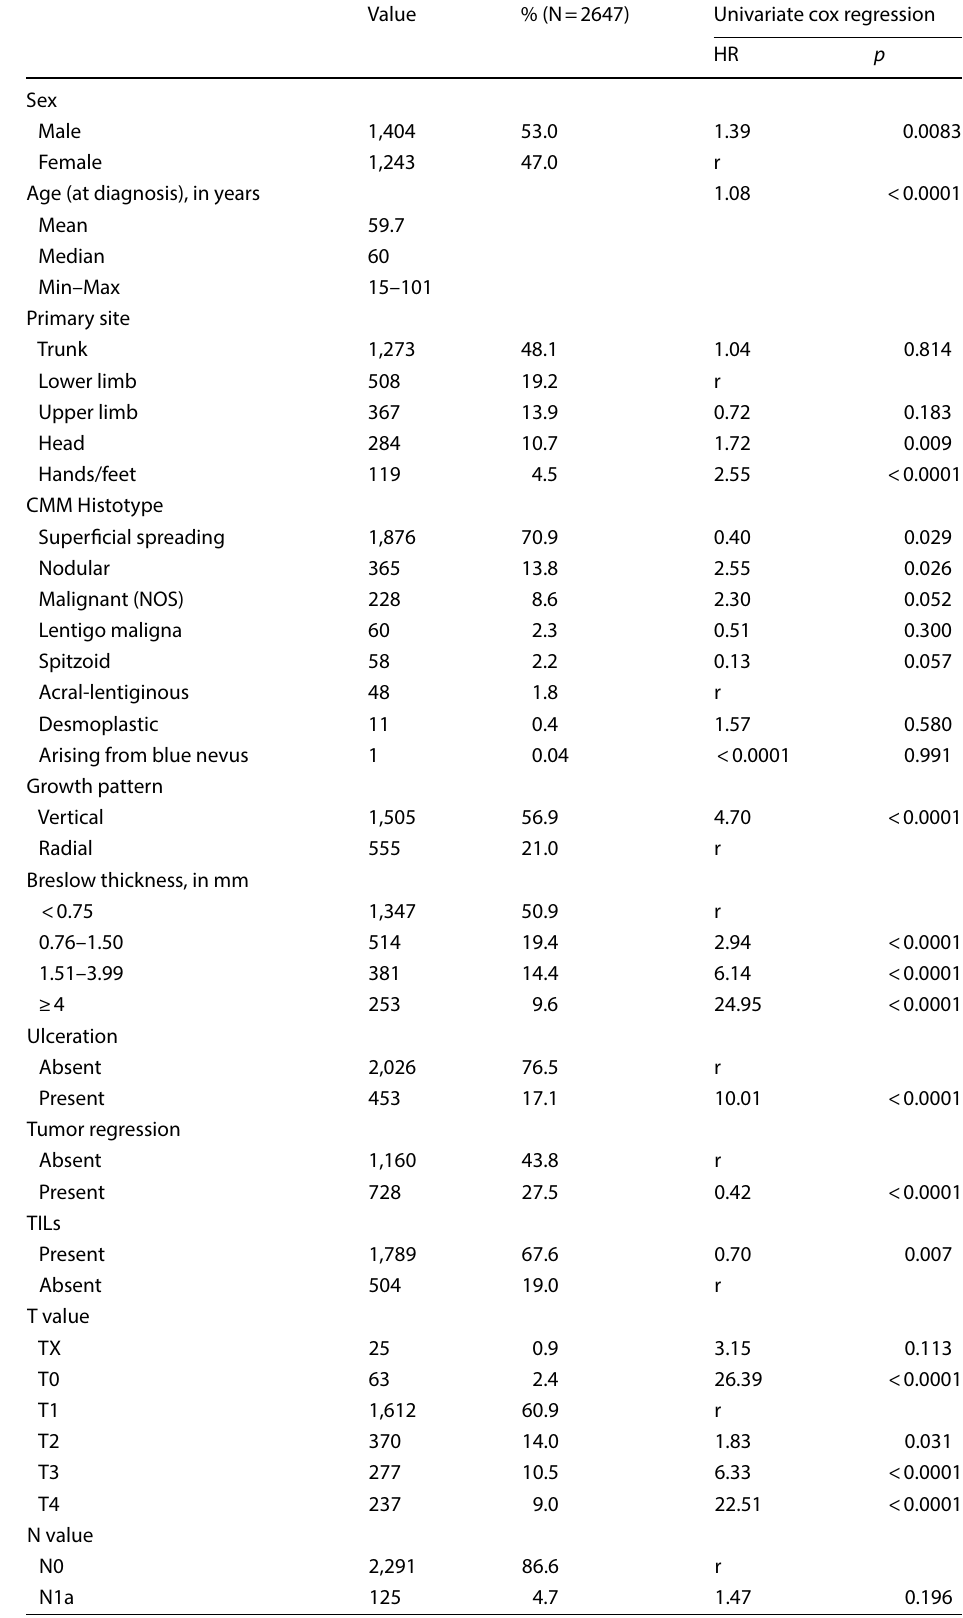
Table 1 Clinical-pathological characteristics of the study population and univariate Cox regression hazard ratio (HR) estimates and p-values